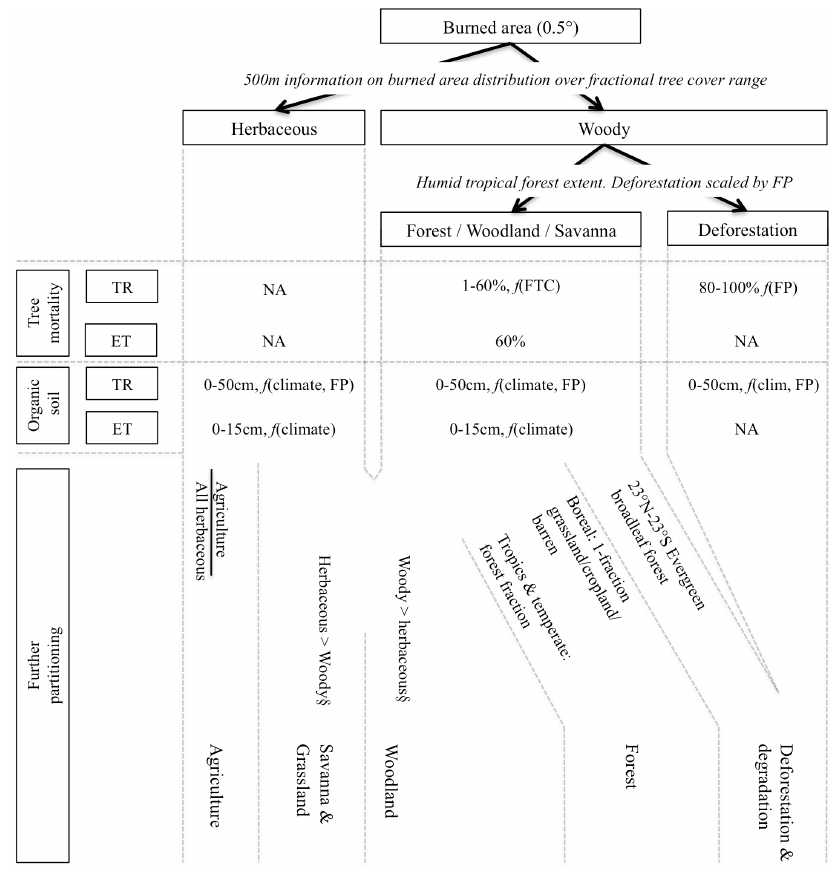
Fig. 4. Flowchart of our approach to partition burned area and emissions into different fire types. FP is fire persistence, FTC is fraction tree cover, TR tropics, and ET extratropics. The tropical “peat” class is not shown, but is based on the fraction of burned area detected in tropical peatlands and the TR scheme for estimating depth of burning into the organic soil. Since boreal fires burned in vegetation classes defined as savanna but more likely resembling open forest, the approach to estimate the forest fraction is based on excluding fires in vegetation classes without woody vegetation (Sect. 2.4.3). Note that fires in grasslands and savannas, woodlands, and forests burn both herbaceous and woody fuels, while agricultural fires burn only herbaceous fuels, and deforestation fires burn only woody fuels. Agricultural and forest fraction of emissions were subtracted before woodland and grassland and savanna burning were